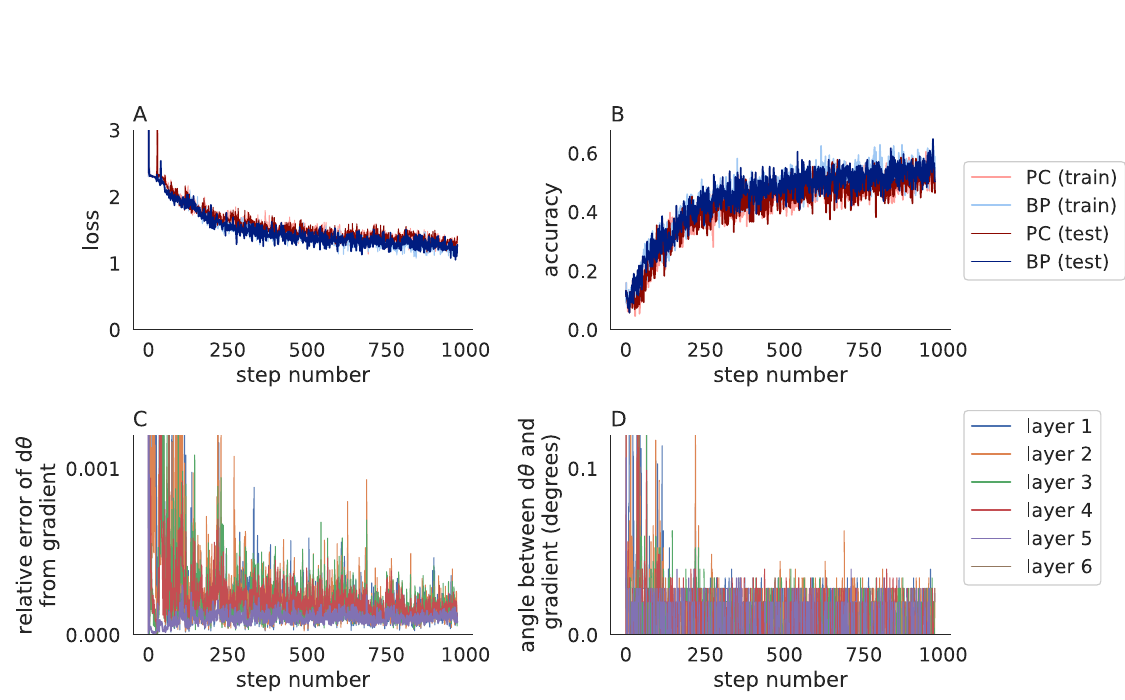
Fig 7. Predictive coding modified by the fixed prediction assumption with η = 1 compared to backpropagation in convolutional neural networks trained on CIFAR-10. Same as Fig 5 except η = 1 and n = L . Predictive coding with the fixed prediction assumption approximates true gradients accurately when η =